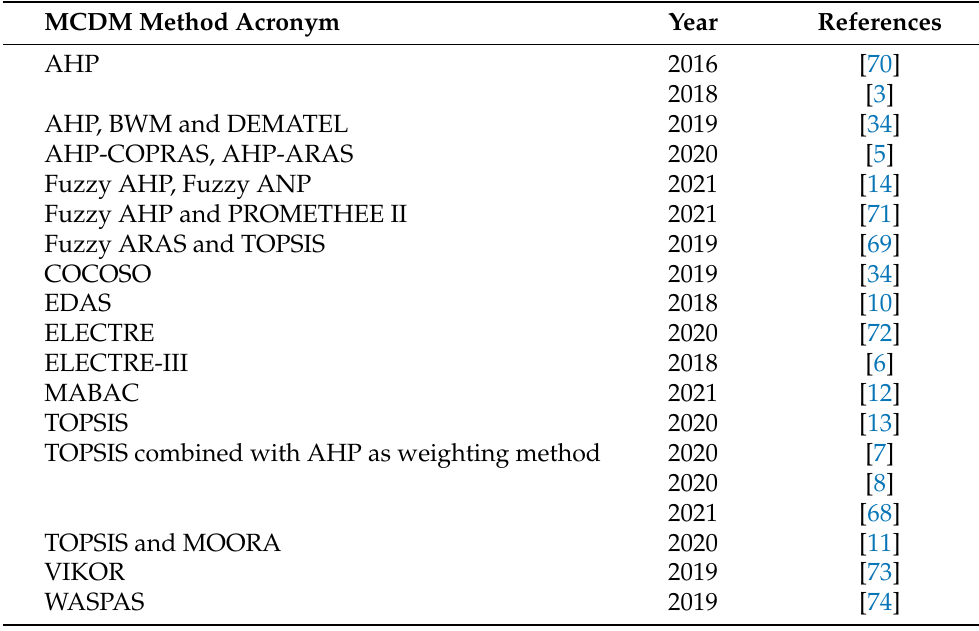
Table 1. MCDM methods used to evaluate mobile phones in recent